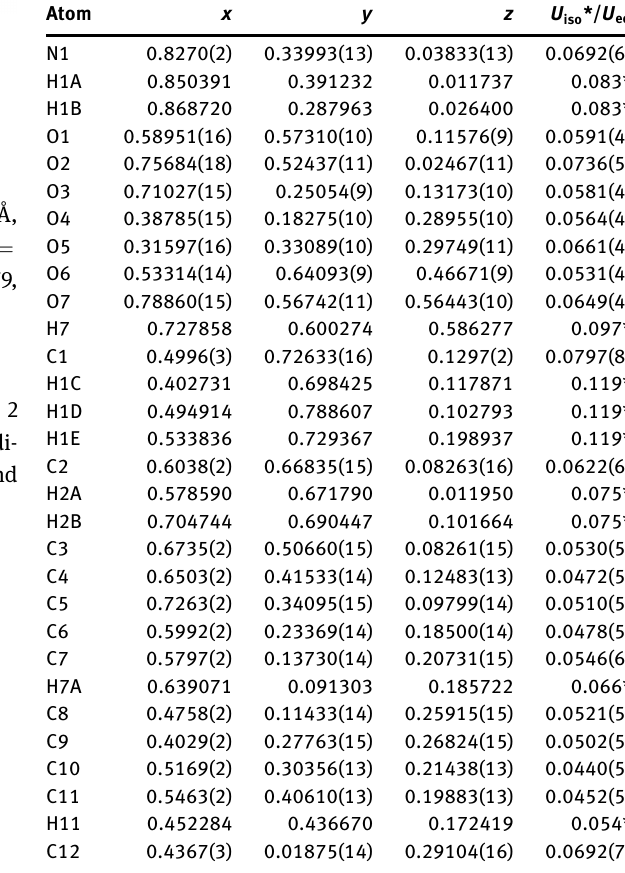
Table 2: Fractional atomic coordinates and isotropic or equivalent isotropic displacement parameters (Å 2